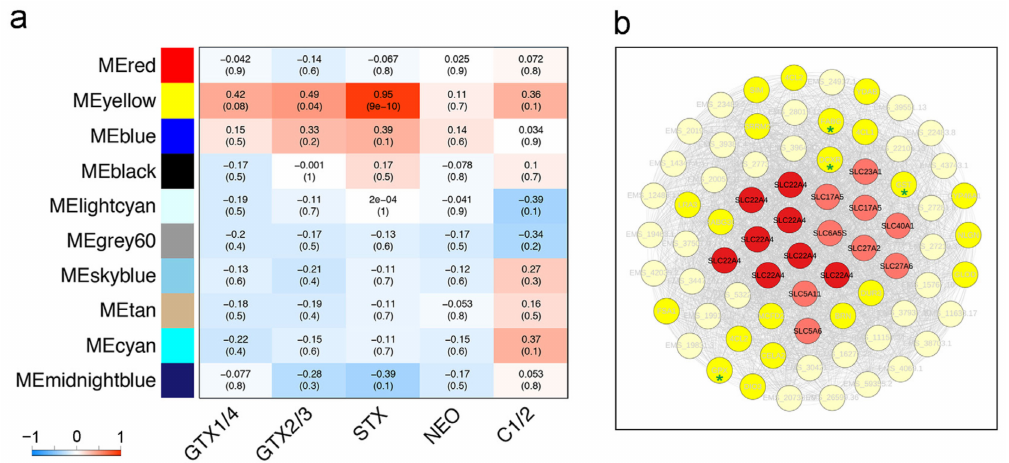
Figure 3. ( a ) Heatmap of module-trait relationships depicting correlations between module eigen- genes and PST contents. Numbers in the table correspond to the correlation r and the p value in brackets. The degree of correlation is illustrated with the color legend. ( b ) Network visualization of hub genes in the yellow module (top 5% highest connectivity). Hub genes are connected by an edge if the topological overlap between them is more than 0.50. Each node represents a hub gene, which is labeled with gene name. Red nodes represent hub genes in SLC family, in which SLC22 s are shown in dark red. The genes related to the oxidation-reduction process are marked with green